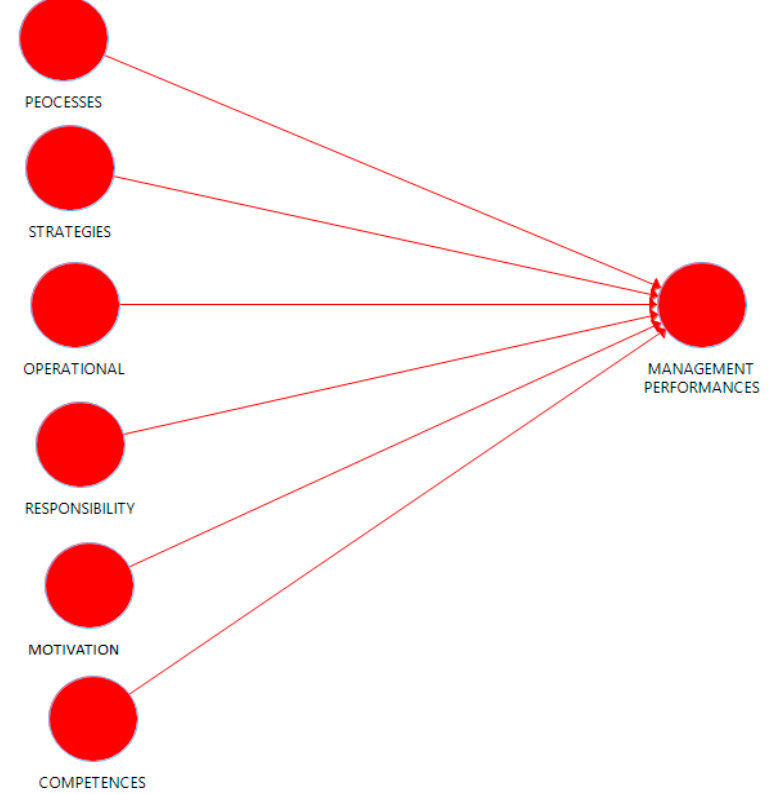
Figure 5. Conceptual structural model with the total quality management (TQM) effects on management performance.